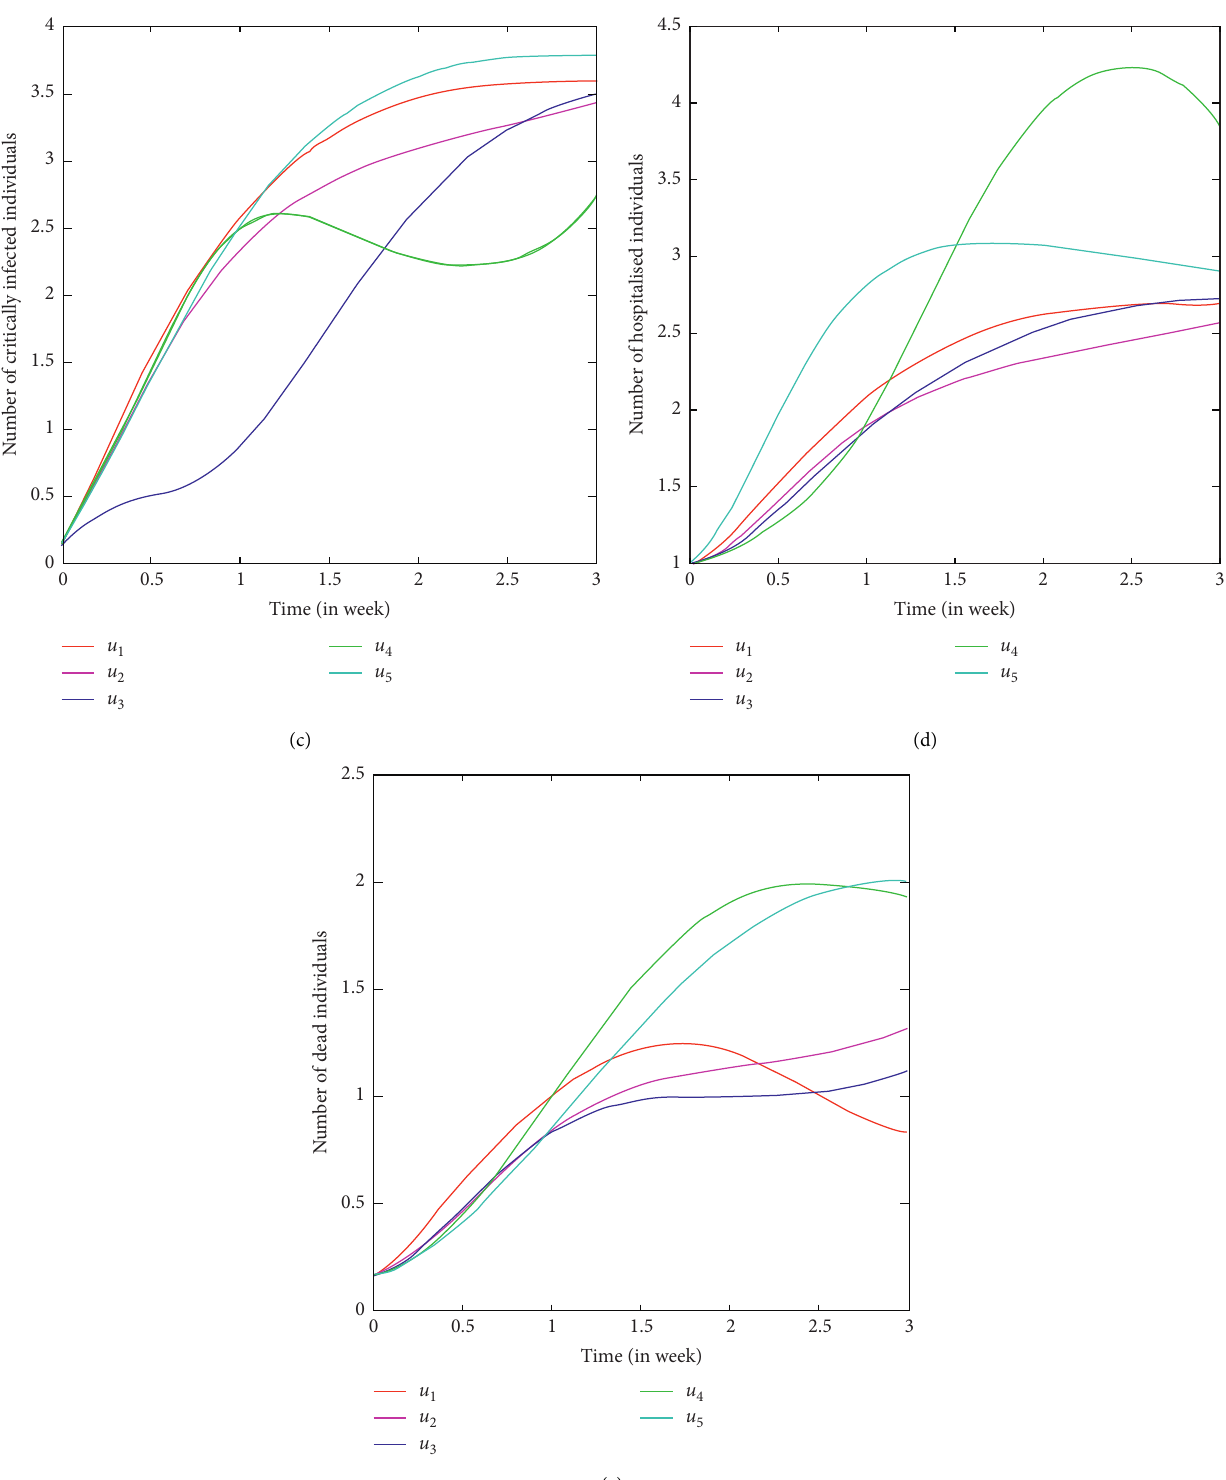
Figure 6: Variation in each compartment under individual effect of control